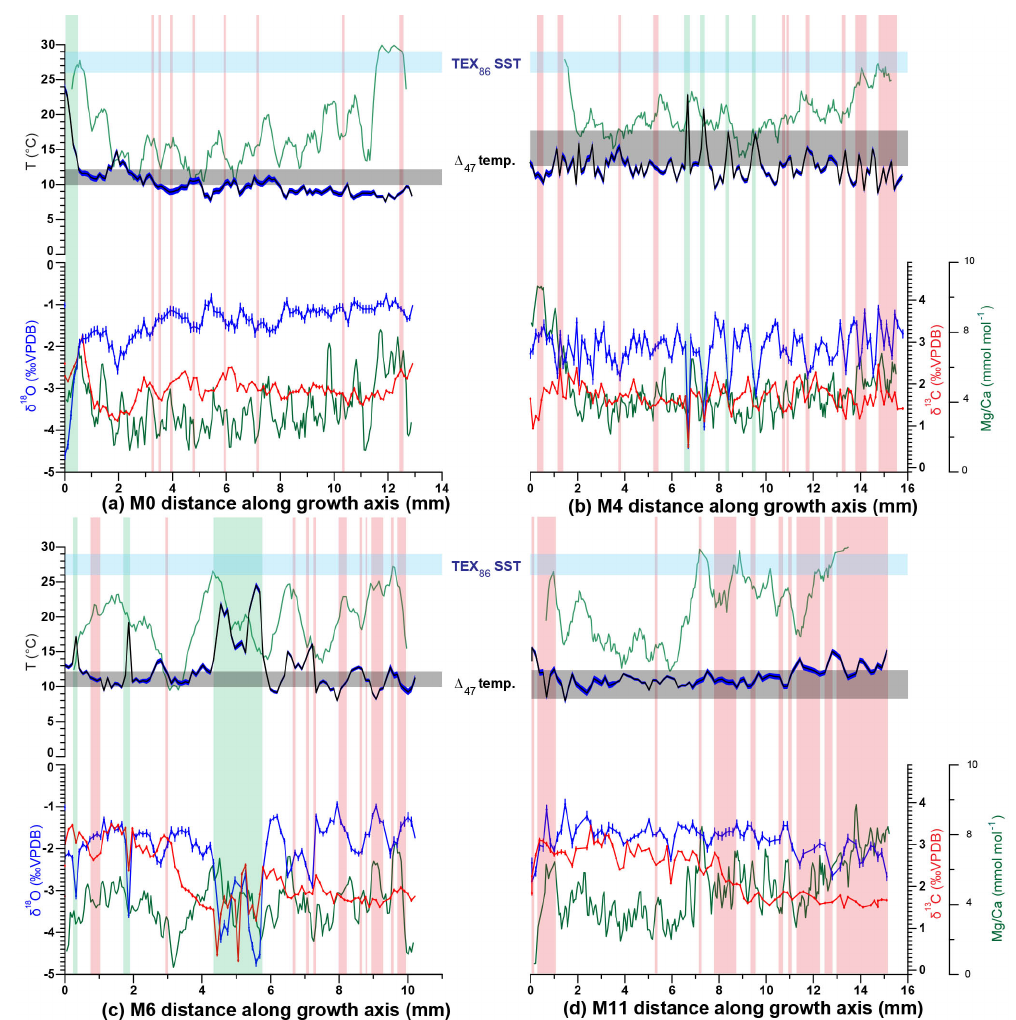
Figure 9. Overview of stable isotope and Mg / Ca records (bottom) as well as tentative temperature and salinity reconstructions (top) based on δ 18 O (blue) and Mg / Ca (green), clumped isotope analysis (grey bars) and TEX H palaeothermometry (light blue bars). Temperatures 86 calculated from δ 18 O records (dark blue on top) are based on the calibration by Hays and Grossman (1991) and the δ 18 O sw value of the clumped isotope measurements indicated in grey. Mg / Ca temperatures (green line on top) were calculated using the calibration reported in Surge and Lohmann (2008) with a factor 3.3 correction for lower Mg / Ca ratios in late Cretaceous ocean water. Temperatures of bulk samples of shells M4 and M11 measured using clumped isotope analysis are indicated by grey bars in graphs of M0 and M6 represent average clumped isotope temperatures of all pristine shell samples (see Table 1). Red and green vertical bars indicate intervals where vesicular calcite was incorporated in the stable isotopic measurements (see Fig.